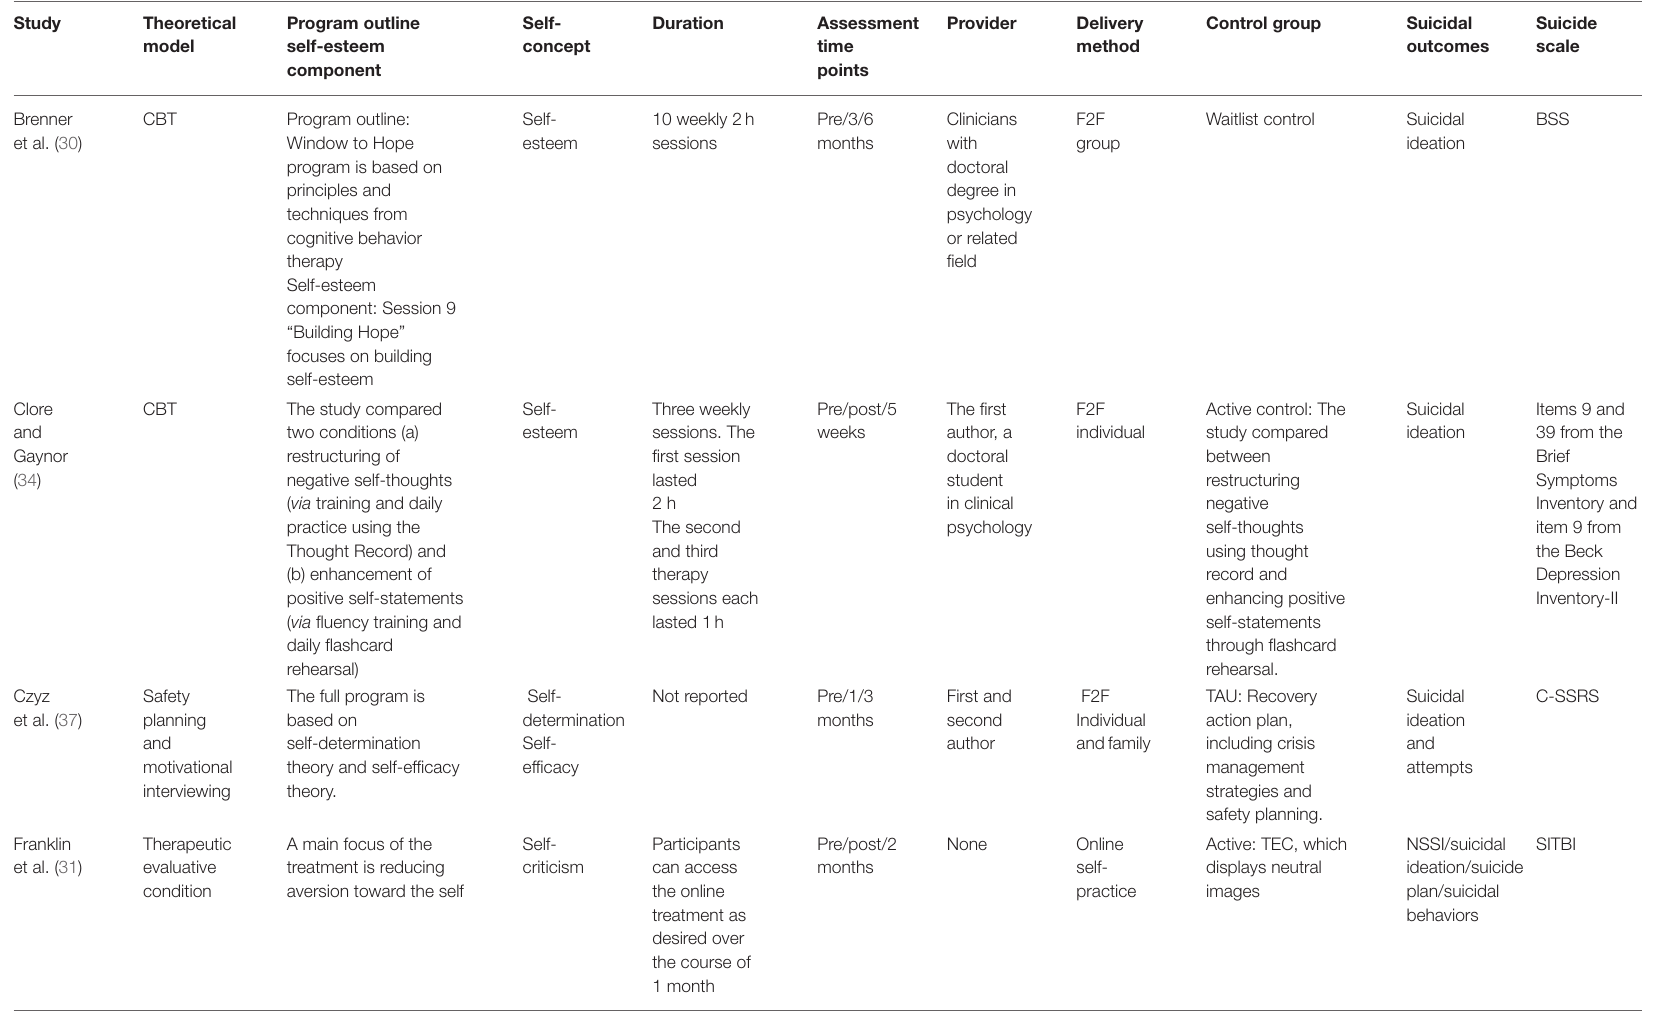
TABLE 2 | Intervention